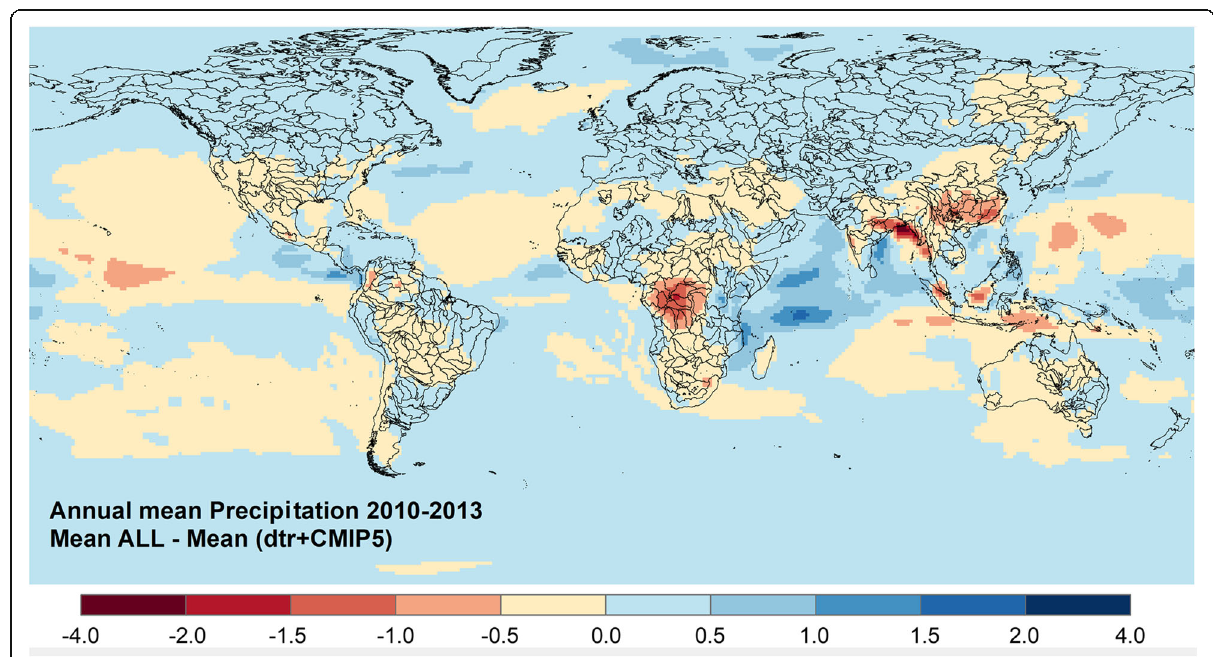
Fig. 3 Difference in the average annual precipitation (mm/day) between the ALL and NAT (average of NAT-dtr and NAT-cmip5) experiments for 2010 –